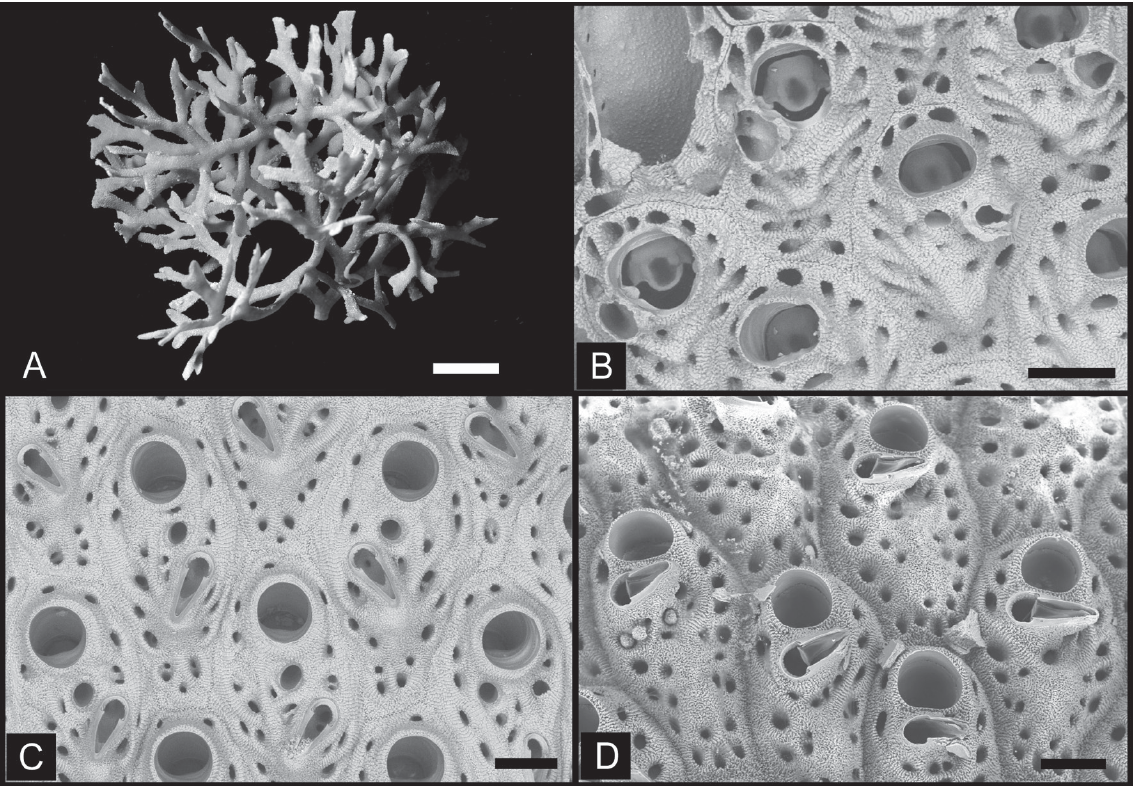
Fig. 4. Adeonella jahanai sp. nov. A . Holotype colony with narrow branches (NsMT-Te1050, okinawa). B . Young autozooids at distal end of branch, showing primary orifices NSMT-Te889. C . Autozooids with elongate frontal avicularia (NsMT-Te889, okinawa). D . Young autozooids with a single triangular avicularium abutting the proximal margin of the peristome (NSMT-Te889, Okinawa). A = optical photograph; B–D = SEM images. Scale bars: A = 1 cm; B–D = 100